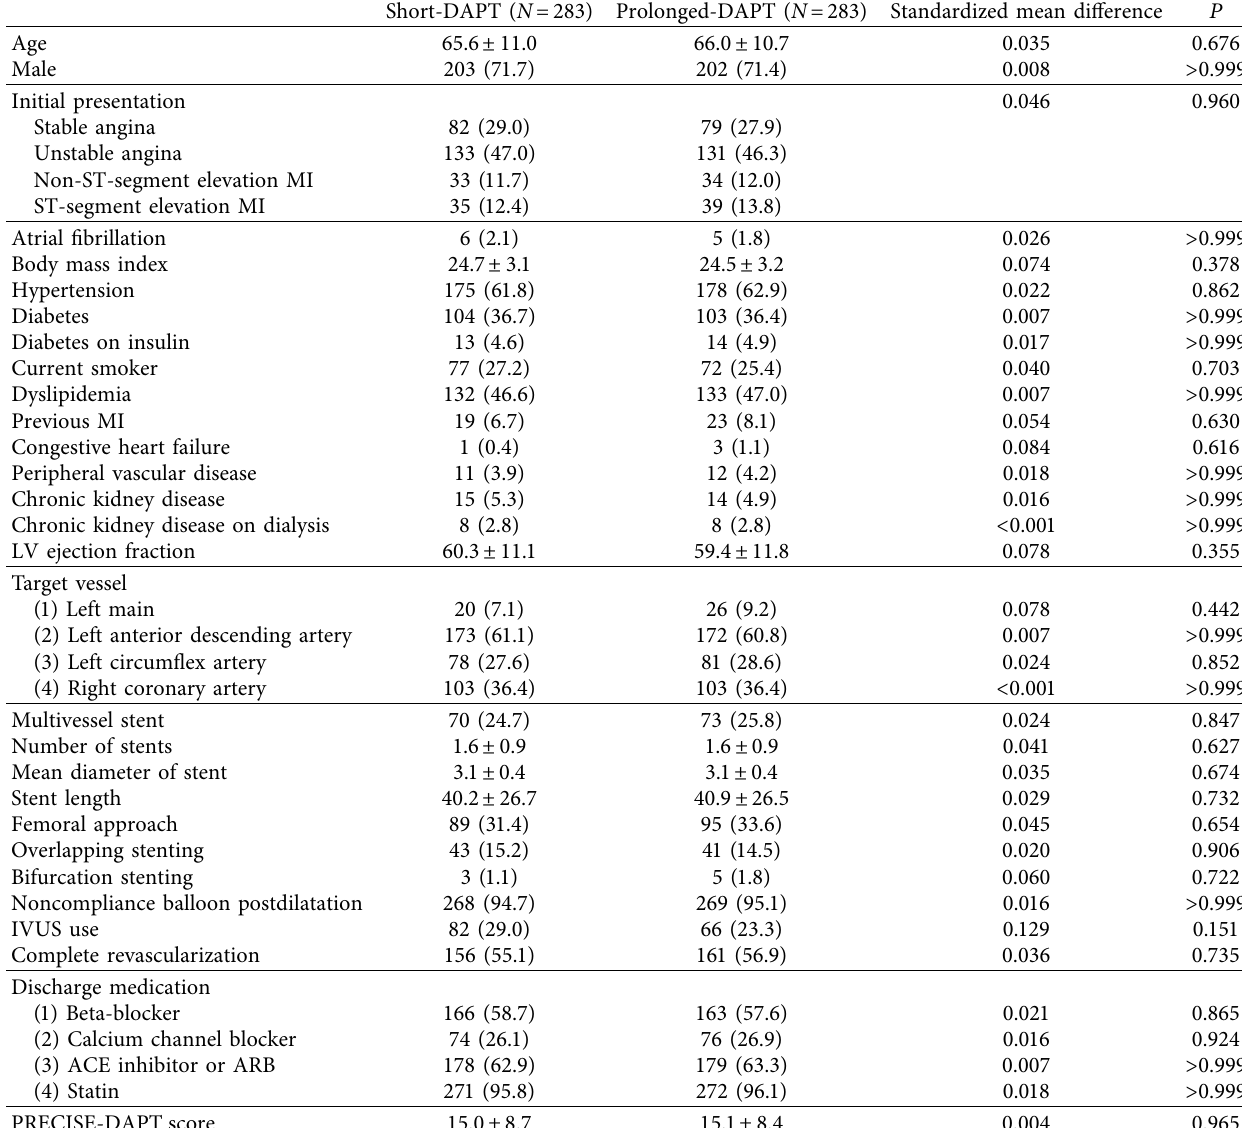
Table 2: Baseline characteristics of the matched